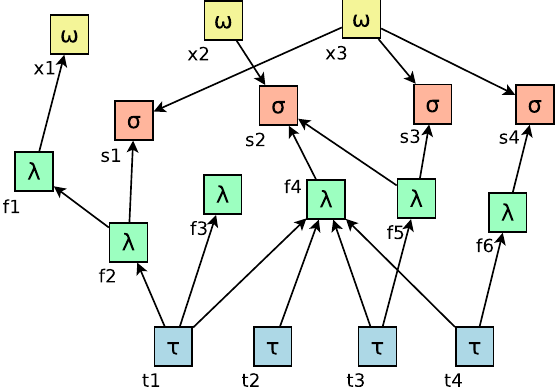
Figure 1. A layered transport level view of the system showing, scheduled tasks ( τ ), stateless functions ( λ ), datasets ( σ ), and external applications ( ω